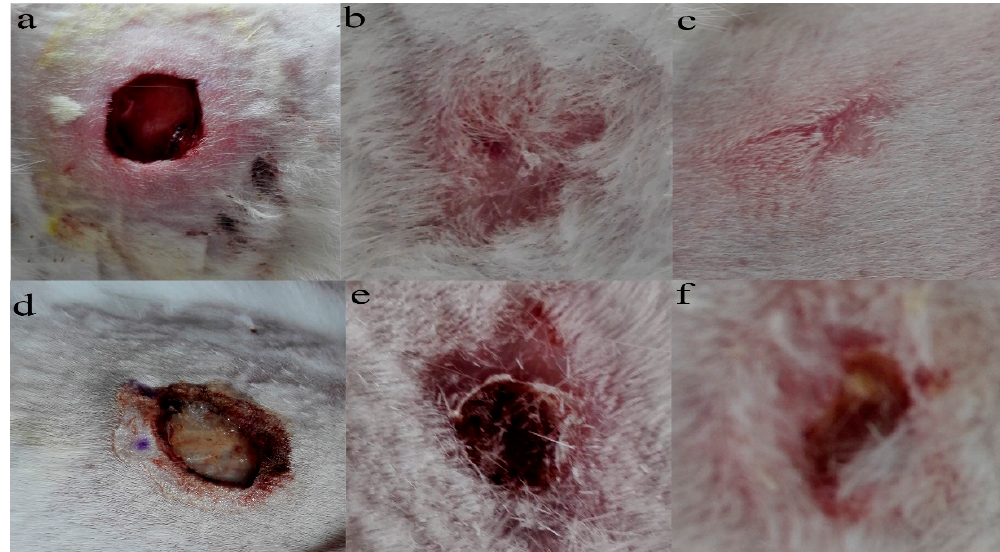
Figure 8. The records of the wound during different periods after being covered by PLA-PTMC and the positive group medical adhesive. ( a – c ) represent the state of the wound covered by PLA-PTMC medical adhesive after 1, 20 and 31 days, and ( d – f ) show the situation of the positive group at the same time, respectively.